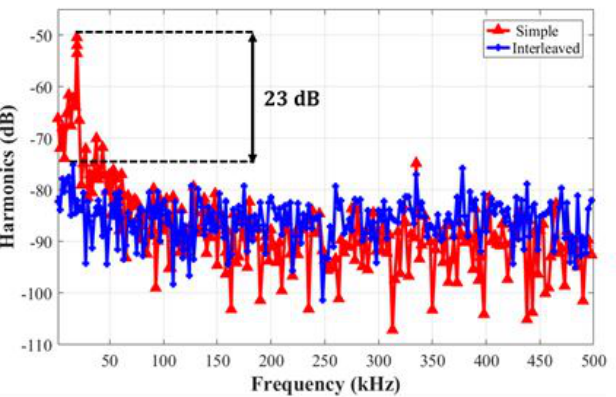
Figure 13. Comparison of the switching current harmonics of the RCFMFD modulation schemes for simple and interleaved buck converters.